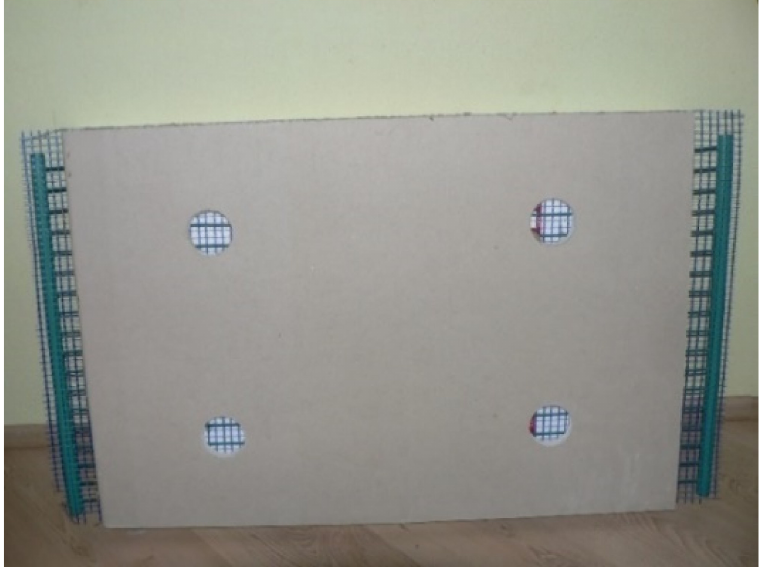
Figure 16. View of a prototype interior panel with capillary mat application for